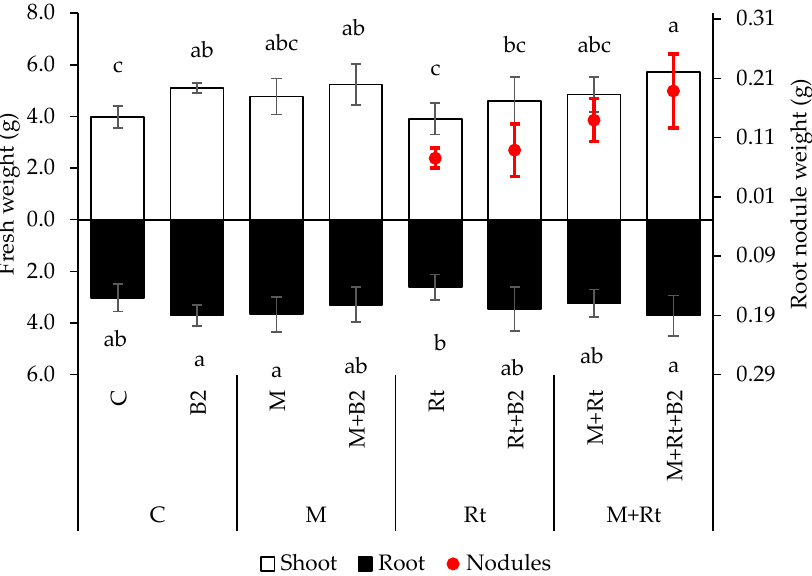
Figure 1. Total fresh weight in Phaseolus vulgaris (common bean) 35 days after being co-inoculated with arbuscular mycorrhizal fungi (AMF) inoculum and Rhizobium tropici CIAT 899. n = 8. Bars repre- sent the mean ± standard deviation. Different letters indicate significant differences among treatments of same tissue, Tukey HSD ( p ≤ 0.05). M, arbuscular mycorrhizal fungi inoculated; B2, irrigated with 50 µM riboflavin; Rt, Rhizobium tropici CIAT 899 inoculation; C, control without inoculation. 3.2. Riboflavin Stimulates Arbuscular Mycorrhizal Fungi (AMF) Colonization Riboflavin increased AMF colonization significantly at 12.5 µM (HSD p ≤ 0.05). Ribo- flavin at 25 µM had the highest AMF root colonization, but there were no significant dif- ferences among the various riboflavin concentrations (Figure 2a). Notably the distribution of the structures changed with the addition of riboflavin, as vesicles increased and ar- buscules and hyphae were reduced. The different riboflavin concentrations had a differ- ential effect on root colonization, with a higher increase of vesicles at 25 µM (Figure 2b).